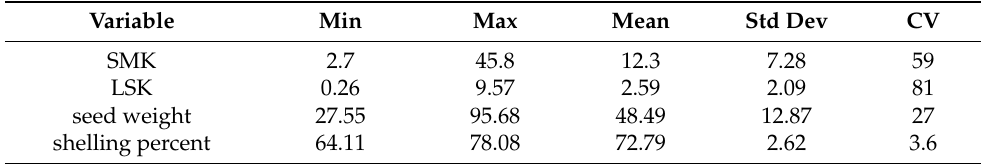
Table 2. Variation for different seed grading traits in diversity